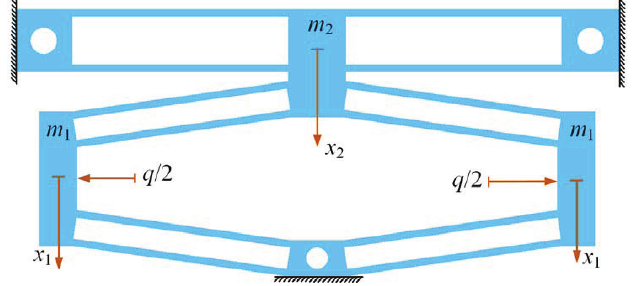
Figure 9. Parallel-guided bridge-type amplifier.